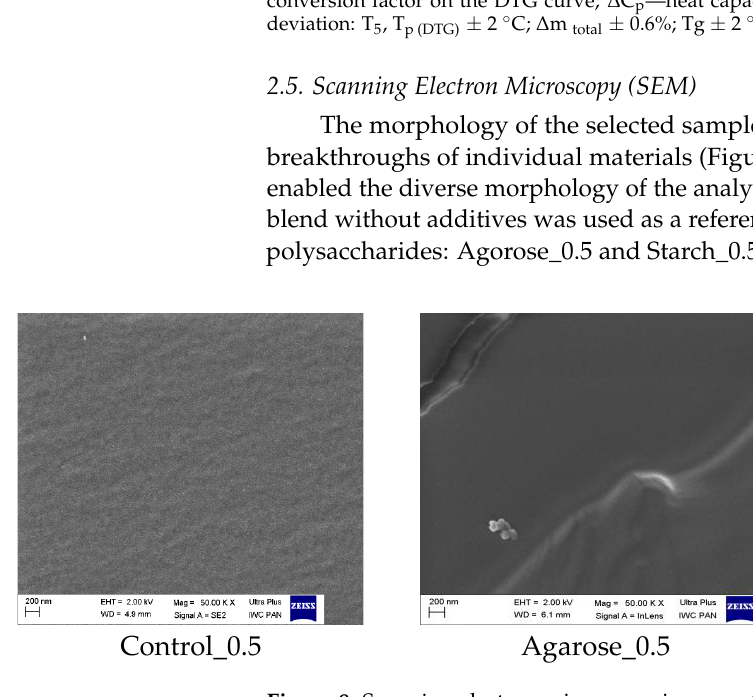
Figure 8. Scanning electron microscope images of gelatin blends.